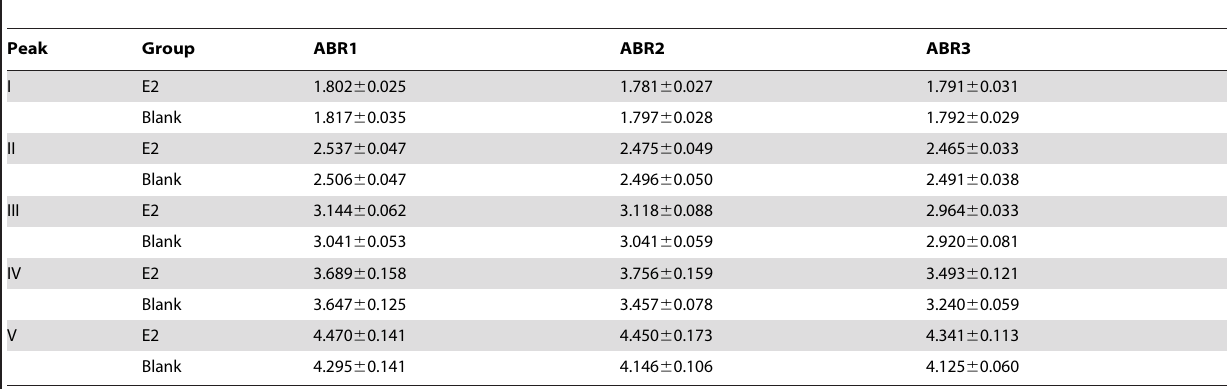
Click ABR latencies (mean 6 sem) at 20 dB above click threshold. All values are in milliseconds.